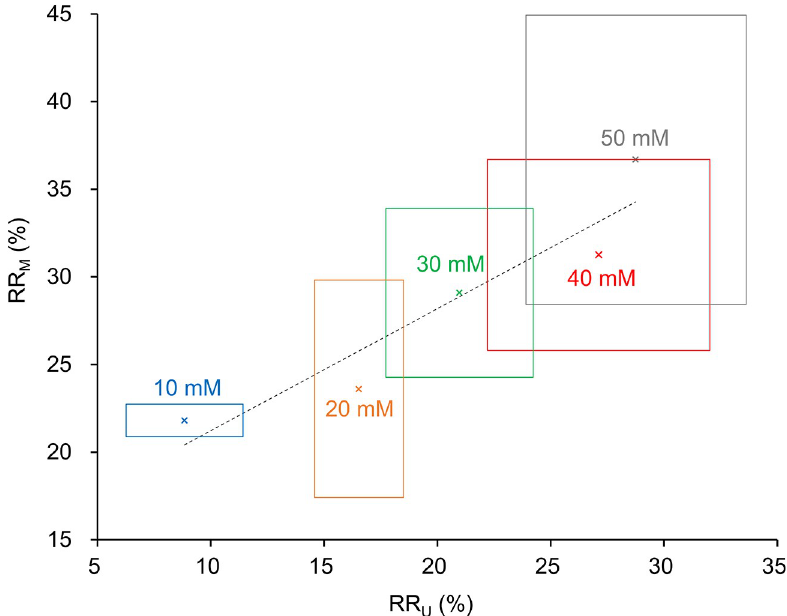
Fig 2. Correlation between the RR U and the RR M of doxorubicin when using different concentrations of γ -CD as carriers. The cross marks represent the mean values, and the side lengths of the rectangles represent the SD. The Pearson’s correlation analysis shows a correlation coefficient of 0.94 (p = 0.016) which exhibits a high correlation between ultrafiltration and microdialysis.